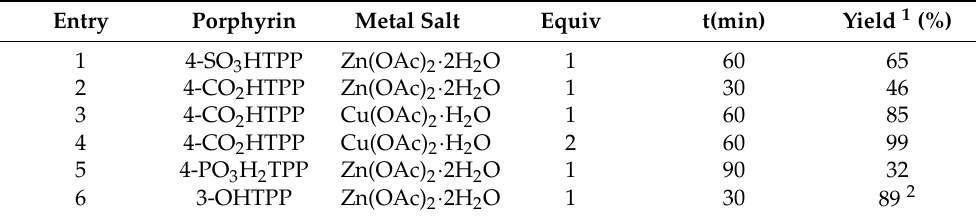
Table 4. Synthesis of zinc and copper complexes of water-soluble porphyrins under ultrasound irradiation in 1 mL of NaOH (2